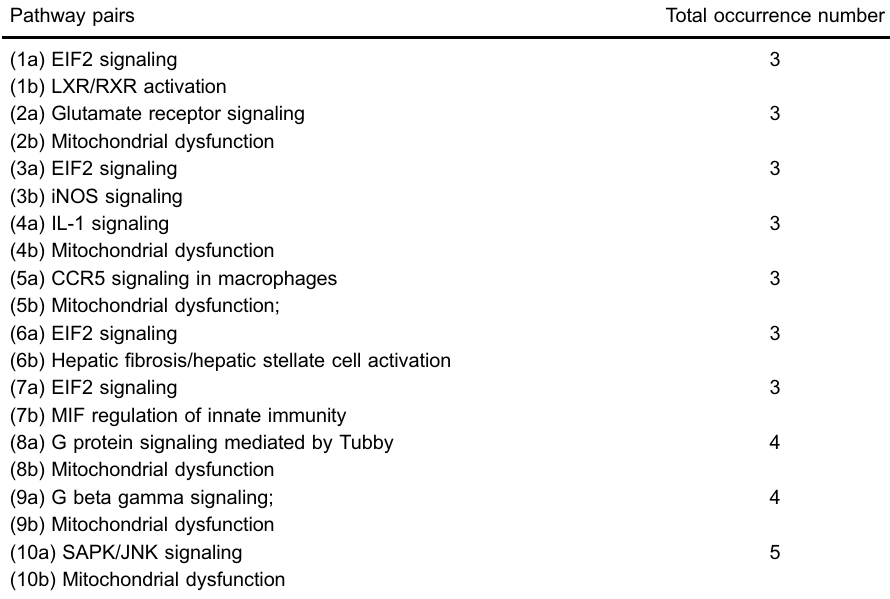
Table 4. Top 10 pathway pairs with occurrence number not less than 3. Pathway